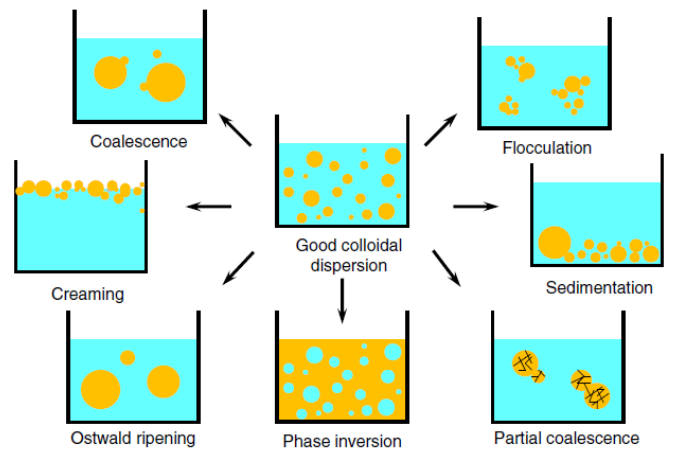
Figure 1. Mechanism for the destabilization of emulsion system [5].